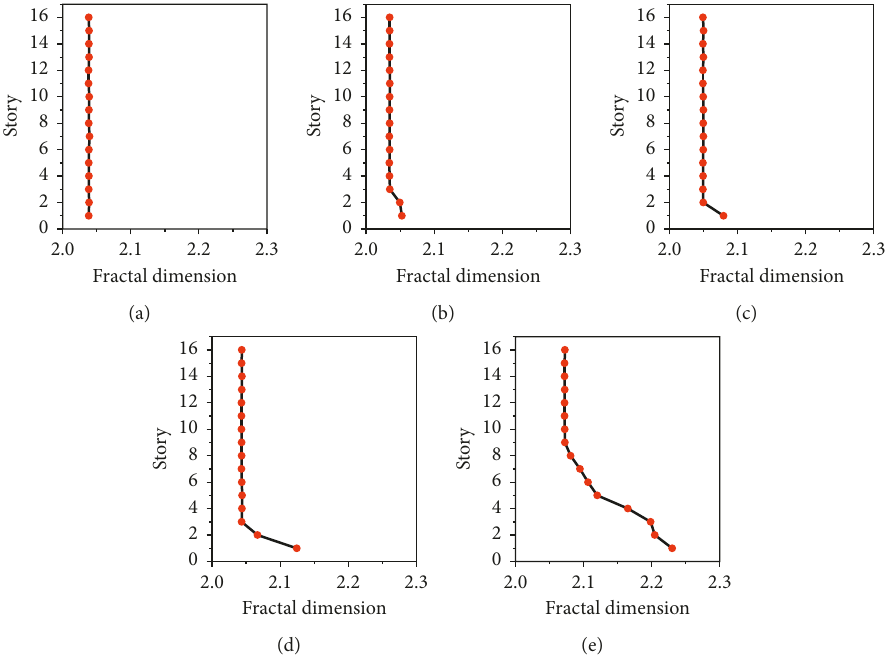
Figure 24: FDs of the TFFs of interstory displacements of the structure under Northridge ground motion for Cases 6–10. (a) Case 6, (b) Case 7, (c) Case 8, (d) Case 9, and (e) Case